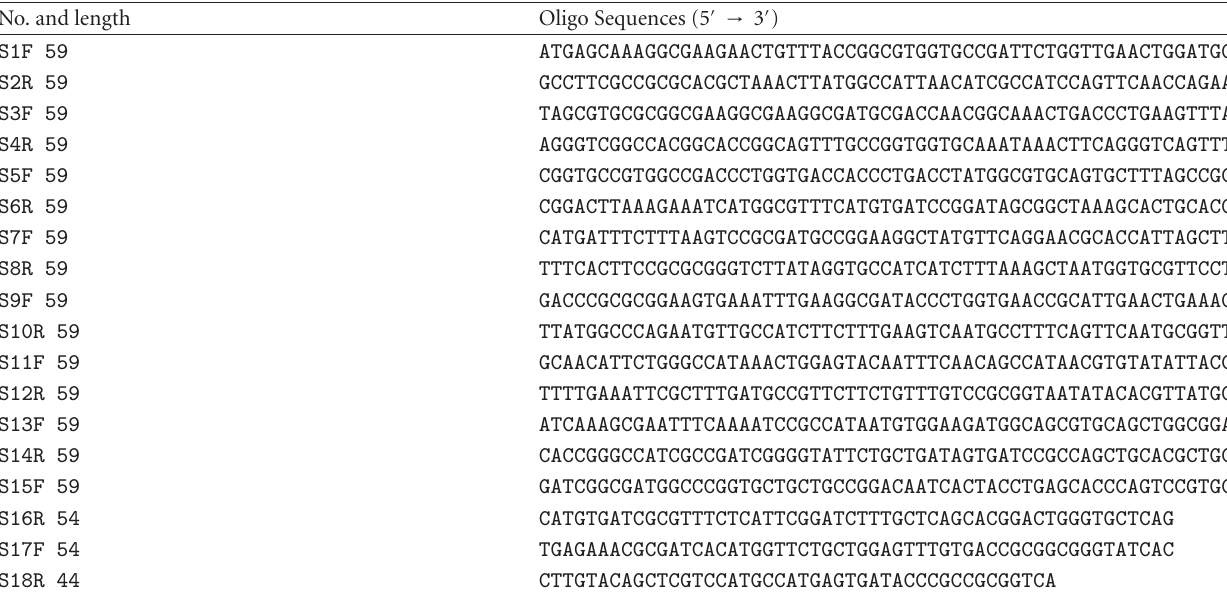
Table 1: Primers for whole gene synthesis of superfolder